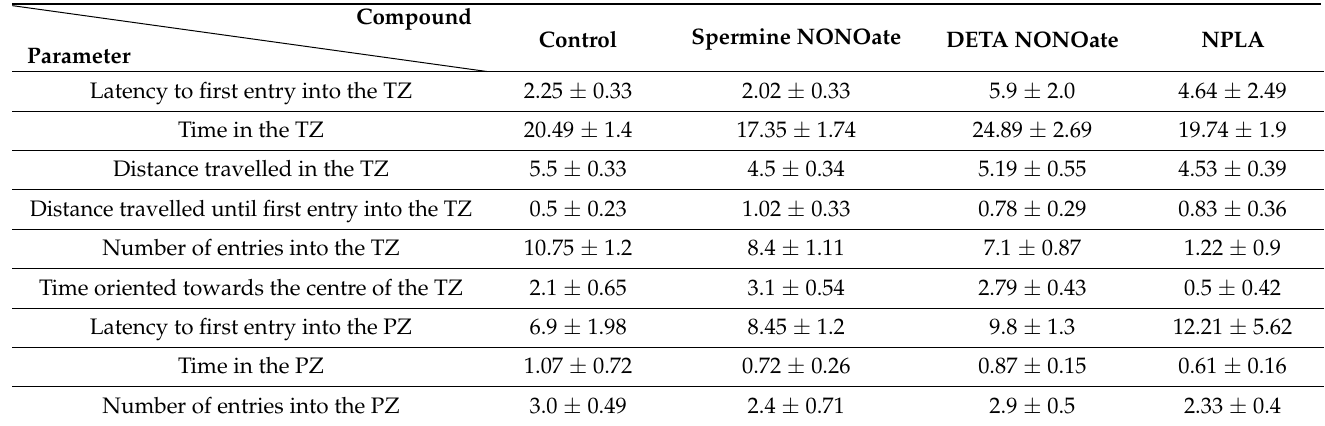
Table 1. The activity of investigated compounds given alone in the MWM. TZ—target zone; PZ—platform zone. The results are presented as means ± SEM. The compounds were administered at a dose of 0.5 mg/kg (N = 8).